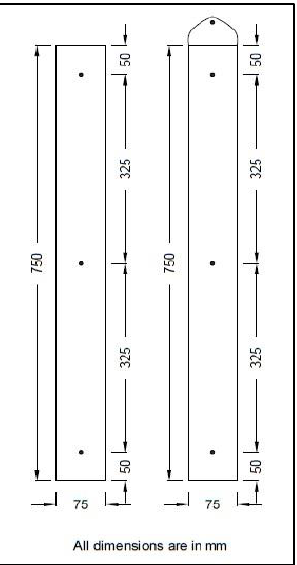
Figure 13. Placement of thermocouples for the conventional and mimicked columns. The black dots represent the thermocouples that were placed inside the columns.